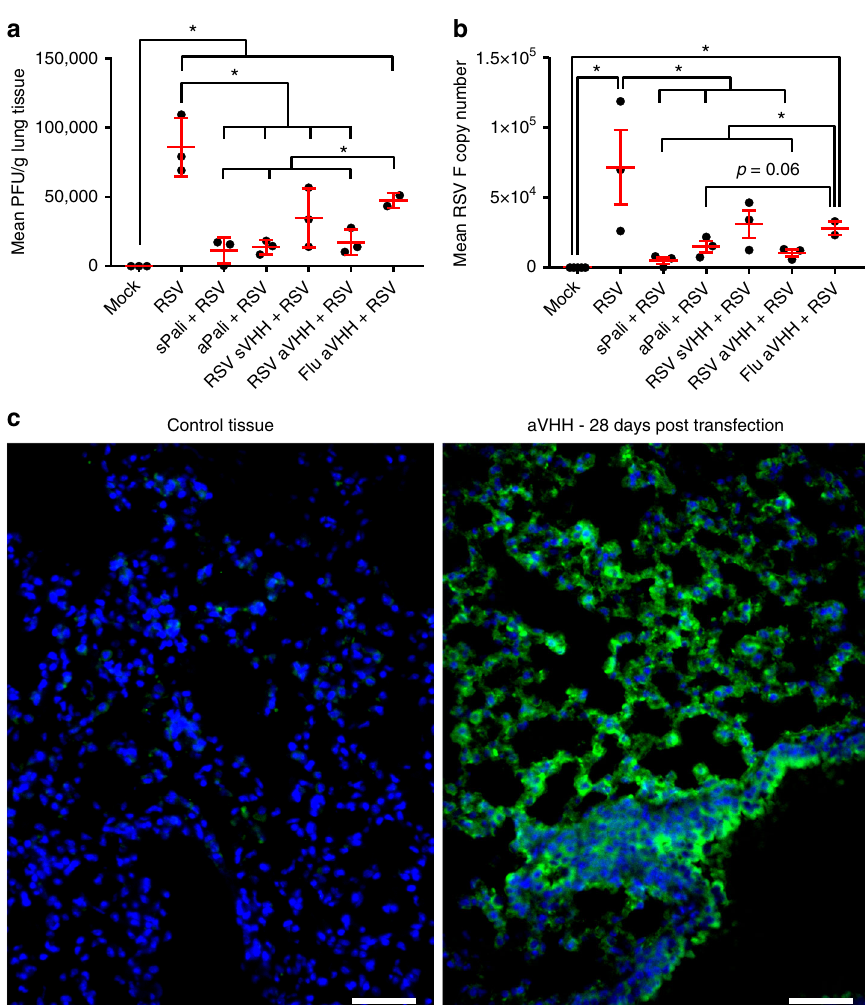
Fig. 7 Anchored anti-RSV VHH protects from delayed RSV infection. Mice lungs were transfected with 100 μ g of naked aPali, sPali, RSV sVHH, RSV aVHH, or Flu aVHH mRNA. RSV and negative controls are indicated. 7 days later, mice were infected with RSV L19. At 4 days post infection, mice were sacri fi ced and lungs were excised. a Virion content of mice lung homogenate supernatants was assayed by plaque assay. Error bars represent standard deviation. Asterisk indicates p < 0.05 ( t -test, one tailed). b Mean RSV F copy number was determined by qRT-PCR. Error bars represent standard deviation Asterisk indicates p < 0.05 ( t -test, two tailed). c Mice lungs were transfected with 100 μ g of naked RSV aVHH mRNA. Control tissue was transfected with saline only. Mice lungs were harvested 28 days later and prepared for cryosectioning and were stained for VHH (green). Scale bar represents 50 μ